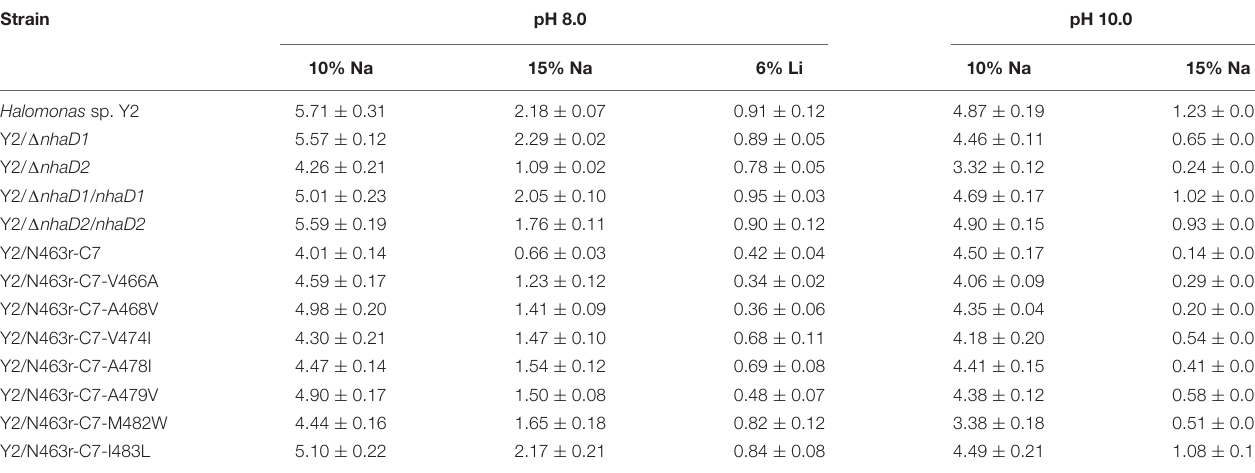
TABLE 4 | Complementation growth of constructed mutants to the wild type Halomonas sp. Y2. Strain